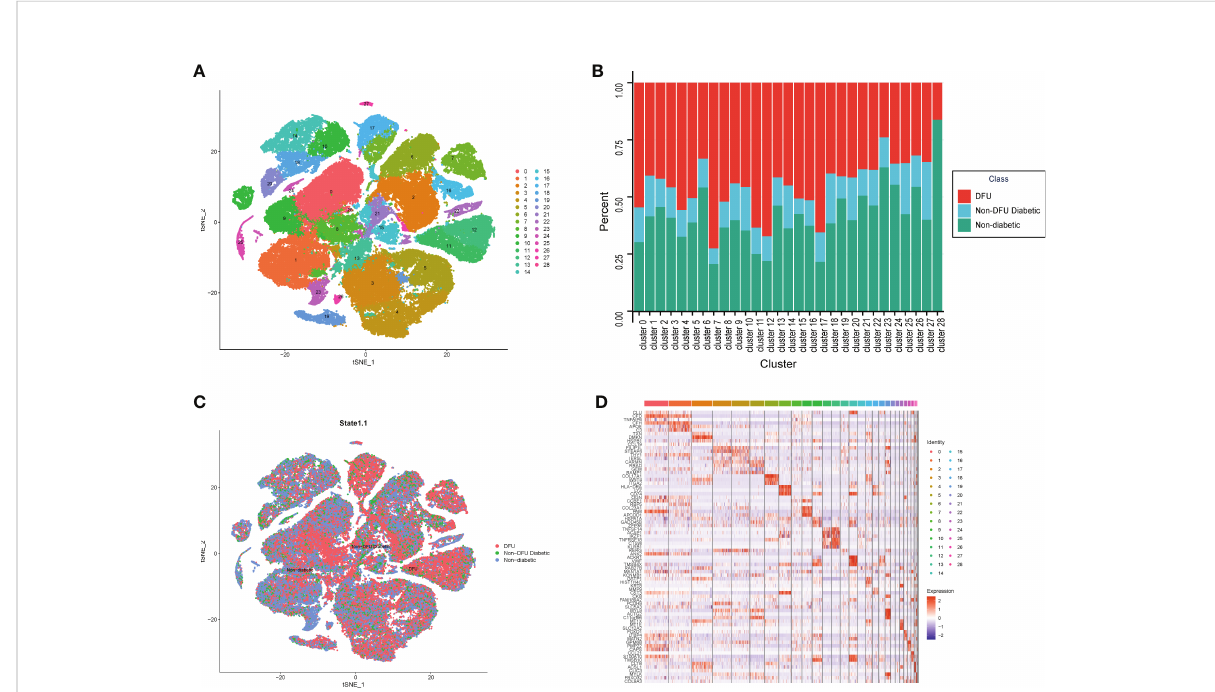
FIGURE 2 The single cell atlas of DFU, Non-DFU diabetic and Non-diabetic. (A) The clusters of single cell atlas using the t-SNE for visualization. (B) The spinogram of the percentage of different cell subtypes (c0-c28) in different groups (DFU, Non-DFU and Non diabetic). (C) The cell clusters split by different groups (DFU, Non-DFU and Non diabetic). (D) The gene expression heatmap of top mark genes of each cell